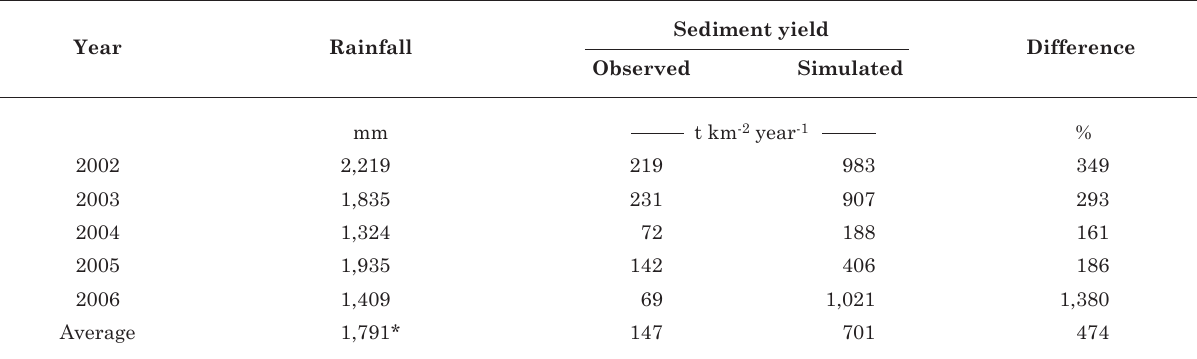
table 4. simulation results of specific sy obtained by the swat model simulation and compared with the observed values (2002 to